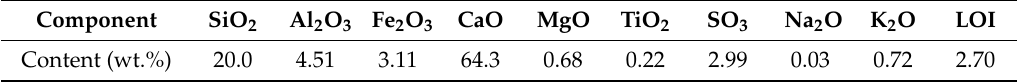
Table 3. Chemical composition of Portland cement.